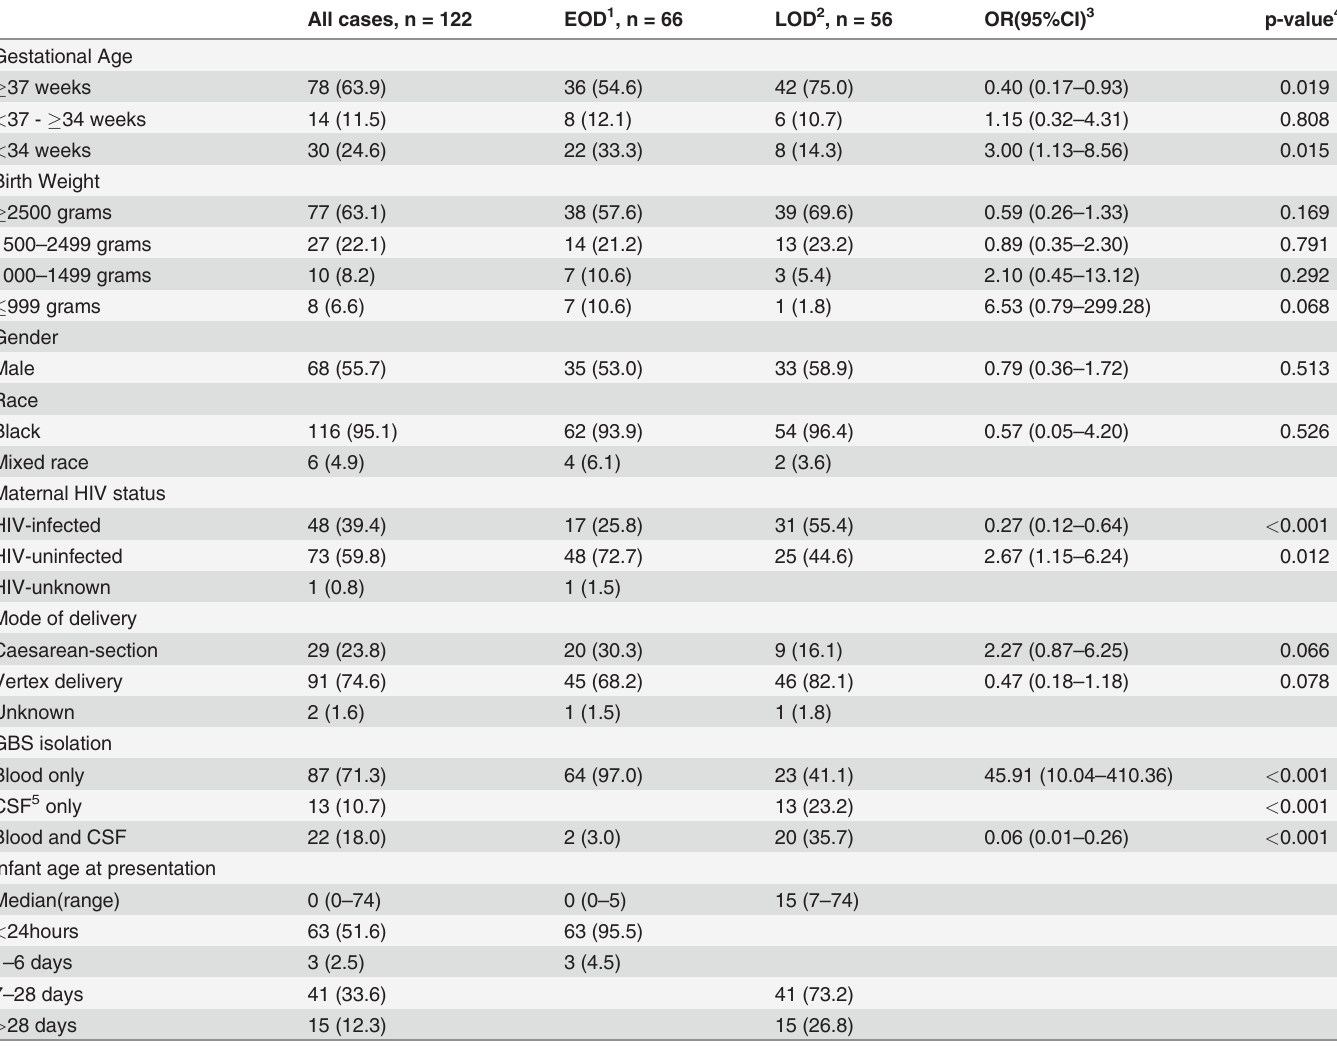
Table 1. Demographic characteristics of infants with invasive Group B Streptococcal (GBS)